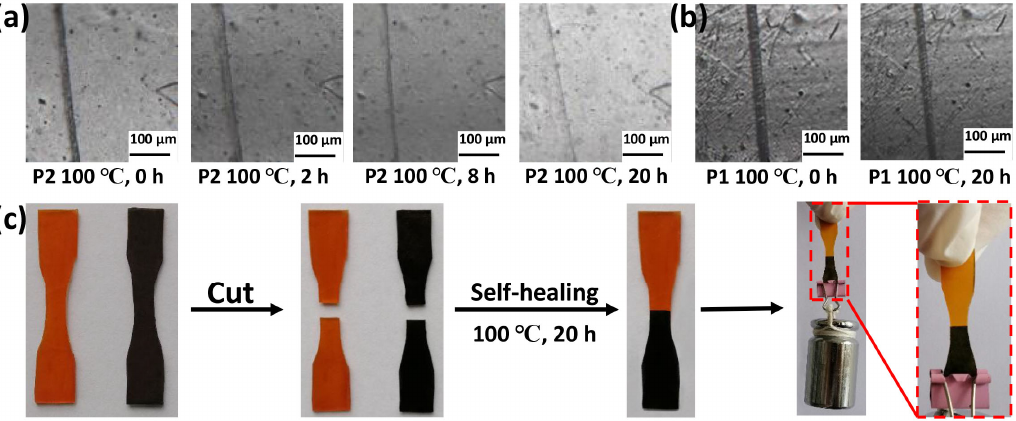
Figure 6. ( a ) Photographs of scratch self-healed P2 at 100 ◦ C for 0 h, 2 h, 8 h and 20 h; ( b ) the photographs of scratch self-healed P1 at 100 ◦ C for 0 h and 20 h; ( c ) dumbbell-shaped film P2 coated with different colors was spliced, and it self-healed at 100 ◦ C for 20 h, and the self-healed film was suspended from a 500 g weight.